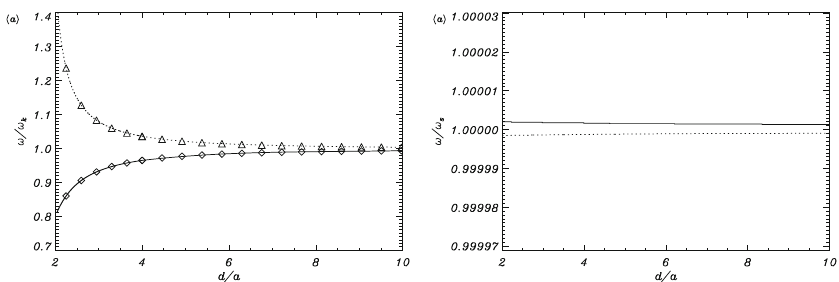
Fig. 48 Fundamental normal modes of two parallel and infinitely long threads (Fig. 46). Left: Ratio of the frequency of the four collective kink-like modes, ω , to the frequency of the individual kink mode, ω k , as a function of the normalised distance between strand axes. Meaning of symbols: S x (solid line), A x (dotted line), S y (triangles) and A y (diamonds). Right: ratio of the frequency of the two collective slow modes, ω , to the frequency of the individual slow mode, ω s , for the S z (solid line) and A z (dotted line). Image reproduced with permission from Soler et al. (2009c), copyright by AAS